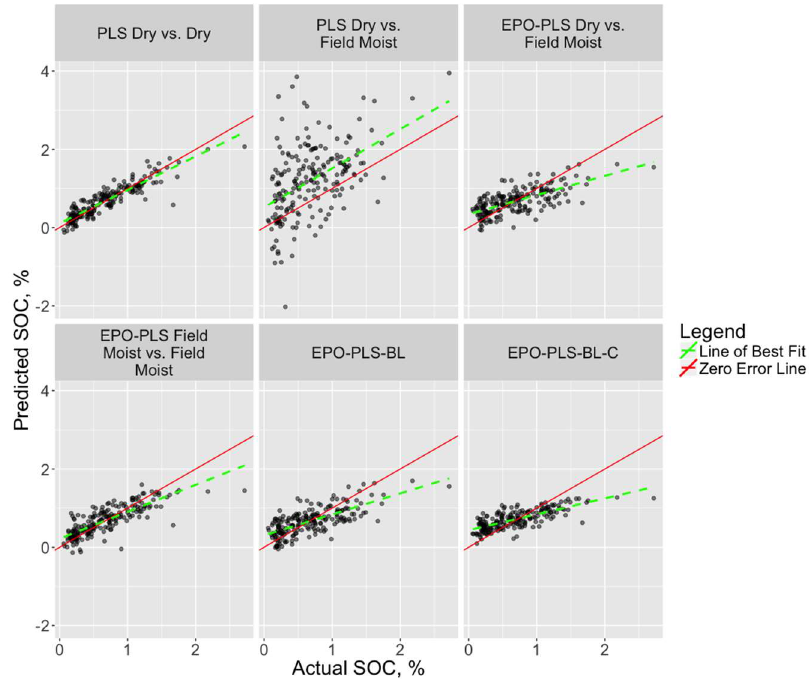
Figure 3. Scatterplots of actual and predicted values for the validation (test) dataset with soil organic carbon as the response. The red line represents the 1:1 (actual = predicted). For a perfect model, all points would fall on this line (zero-error line). The dashed green line represents the line of best fit for the points.